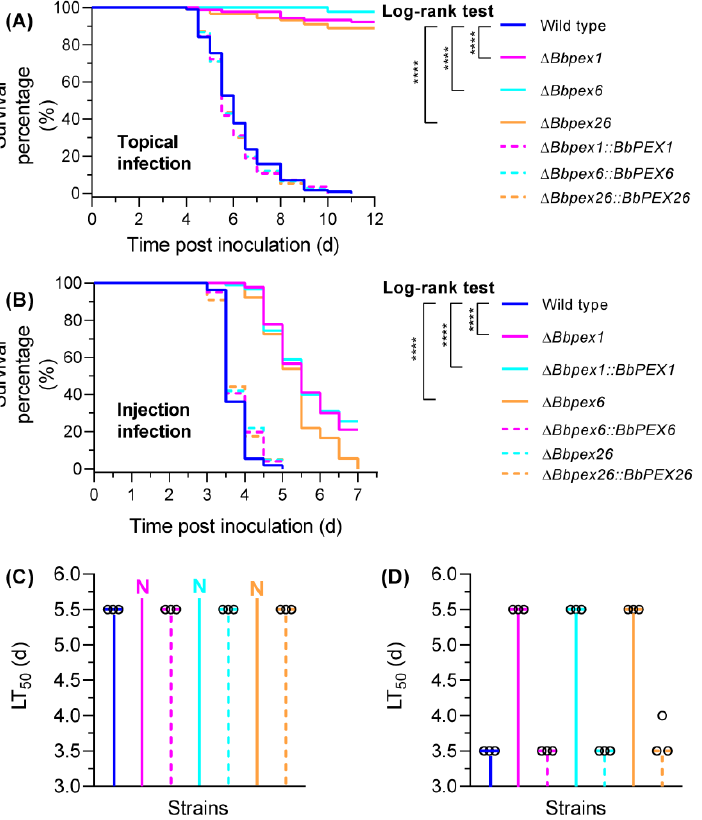
Figure 5. Fungal virulence against the insect host. In the topical infection assay ( A ), the hosts were immersed in the conidial suspension (10 7 conidia/mL). In the intrahemocoel injection assay ( B ), the conidial suspension (5 µL, 10 5 conidia/mL) was injected into the host hemocoel. The infected hosts were reared at 25 °C. The survival percentage was recorded and used to calculate the median lethal time (LT 50 ) for the topical infection ( C ) and intrahemocoel injection assays ( D ) using Kaplan–Meier analyses. The hollow circles indicate the observed values for LT 50 . ‘N’ indicates that the LT 50 value could not be calculated due to an accumulative mortality less than 50%. A log-rank test was used to determine statistical differences between the paired curves. ****: p < 0.0001. After being kept in moist conditions for 4 days, no gene disruption mutants pro- duced obvious mycelia on the cadavers, whereas the wild-type and complemented strains produced thick mycelia (Figure S5B).